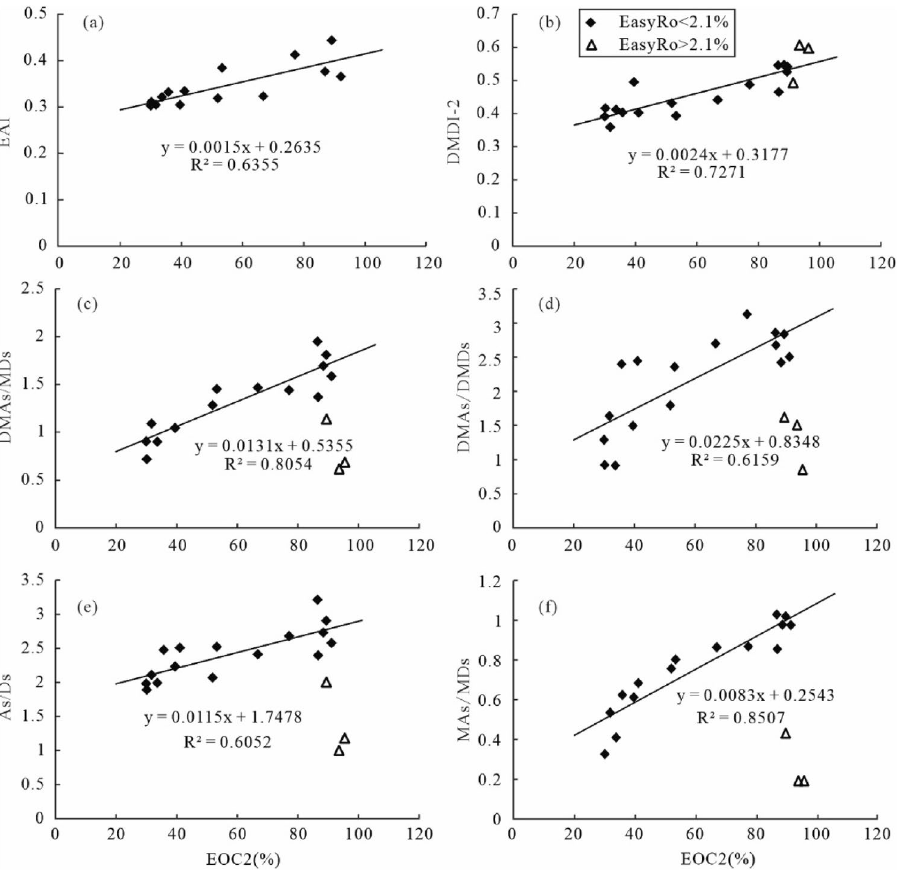
Figure 10. Relationships between diamondoid-related proxies and EOC2 (%): ( a ) EAI; ( b ) DMDI-2; ( c ) DMAs/MDs, ( d ) DMAs/DMDs, ( e ) As/Ds, ( f ) MAs/MDs. Triangles indicate data from EasyRo >